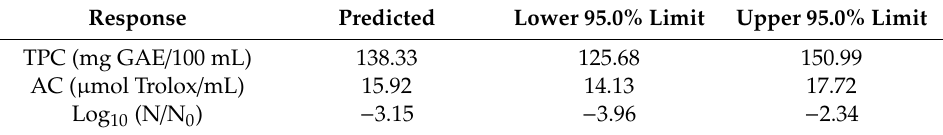
Table 3. Predicted and limit response values for optimum treatment